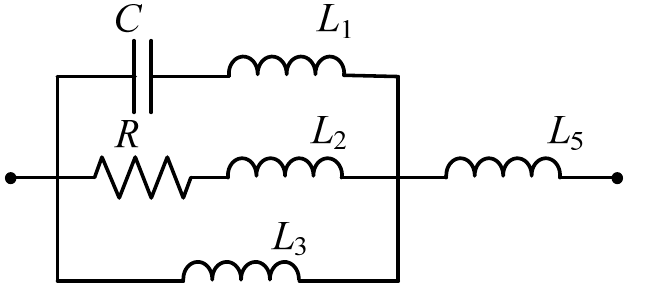
Figure 3. General structure of Y 1 (s).